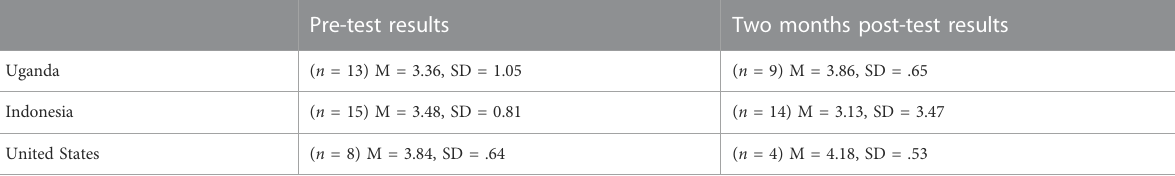
TABLE 4 Comparative results of the Environmentally Responsible Behavior